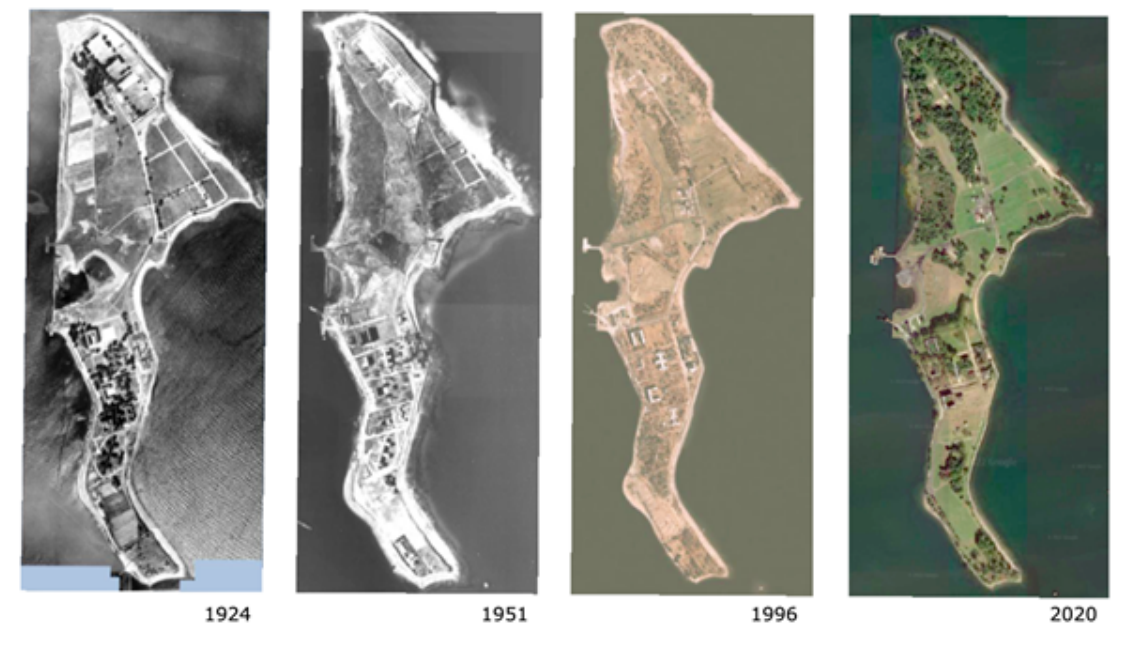
Figure 2. Aerial mapping of Hart Island’s evolution (Source: NYC